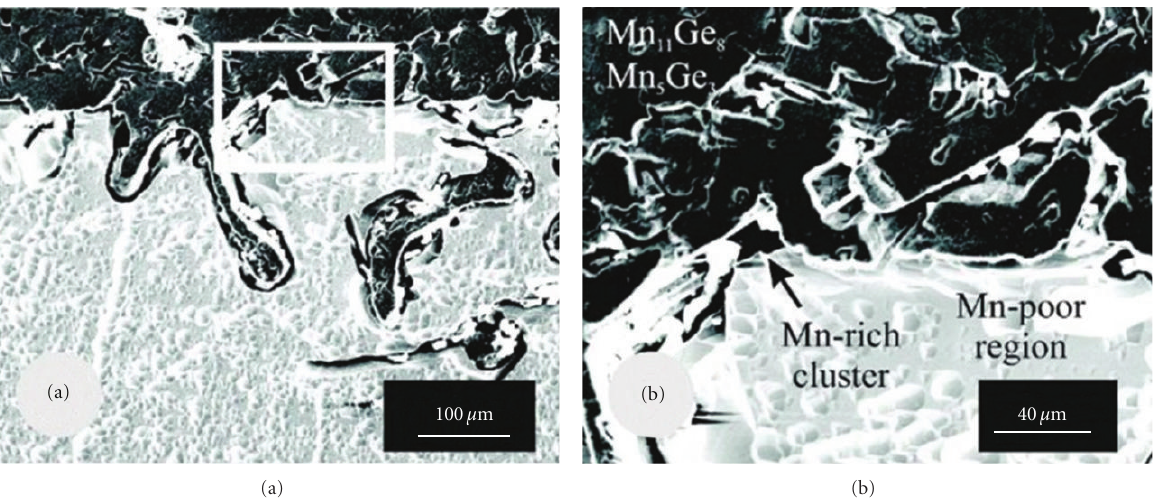
Figure 1: (a) SEM image of the Mn 0 . 1 Ge 0 . 9 crystal surface (dark regions correspond to the Mn-rich phase and bright regions to the Mn-poor phase). (b) SEM image zooming into the field marked in (a). Reproduced from [7]. Copyright ©2007, American Institute of